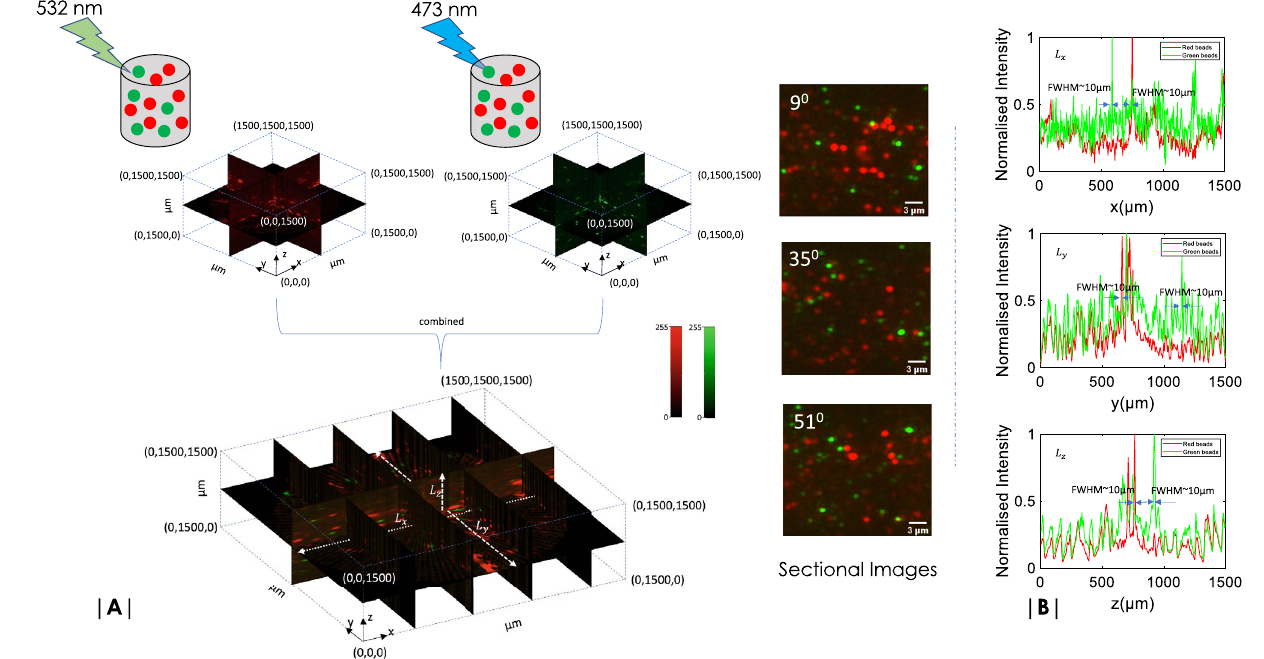
Figure 3. ( A ) OVSS system is calibrated with standard fluorescent beads, Nile Red (Ex/Em: 535 nm/570 nm, ) and Yellow Green (Ex/Em: 505 nm/515 nm). Images are captured at 3 degree rotation with an exposure time of 10 ms and an internal camera gain of 15 dB. A image size of 400 × 400 pixel size is cropped (see Supplementary 3) and processed. Reconstructed volume slices of different planes along with few sectional images (at θ = 9 ◦ , 35 ◦ , 51 ◦ ) are also shown. ( B ) Line plots (along dotted white lines) of slice at different cross-sections of the volume indicate red and green beads that have a FWHM size of ≈ 10 µ